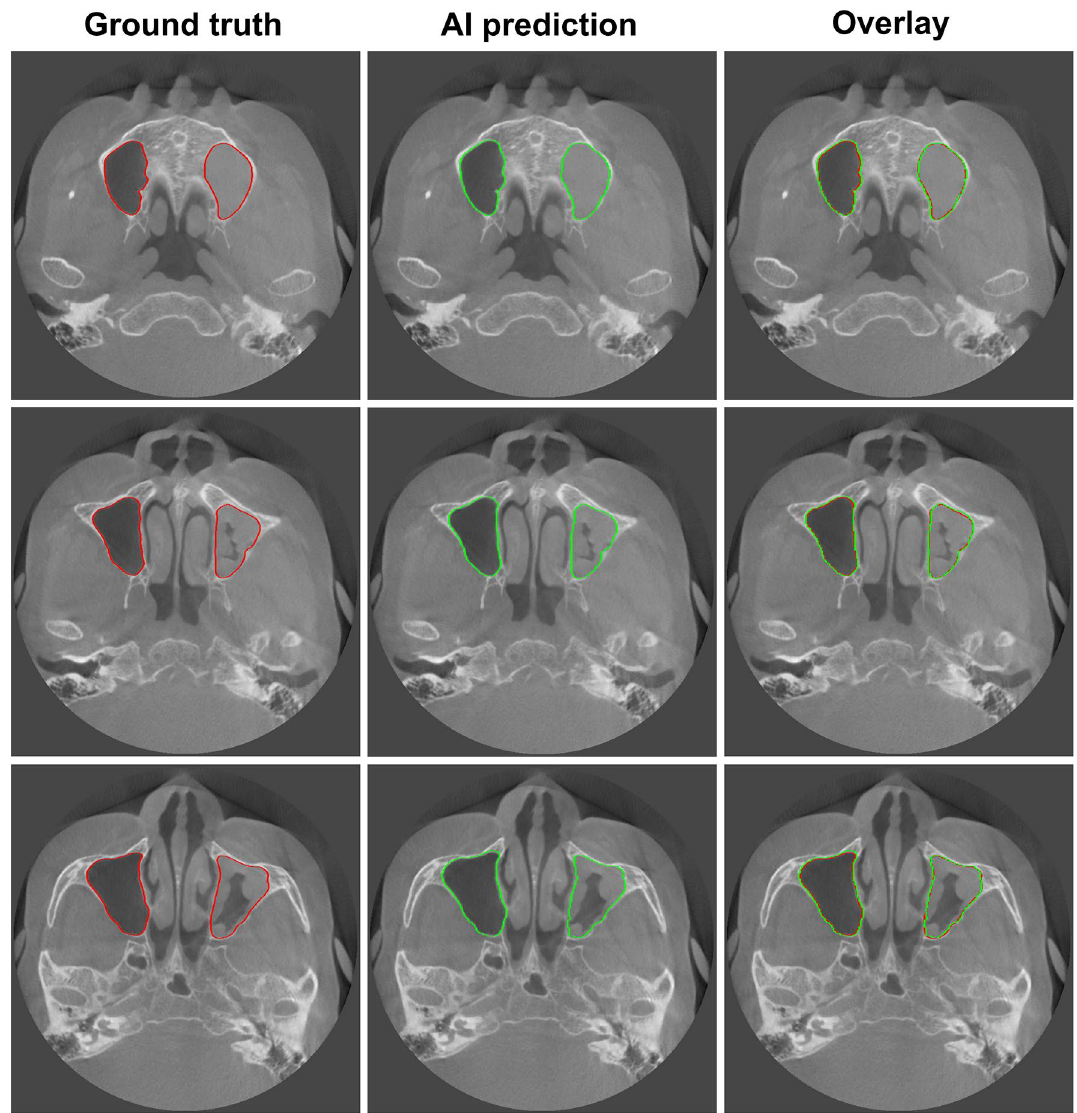
intelligence (AI) prediction